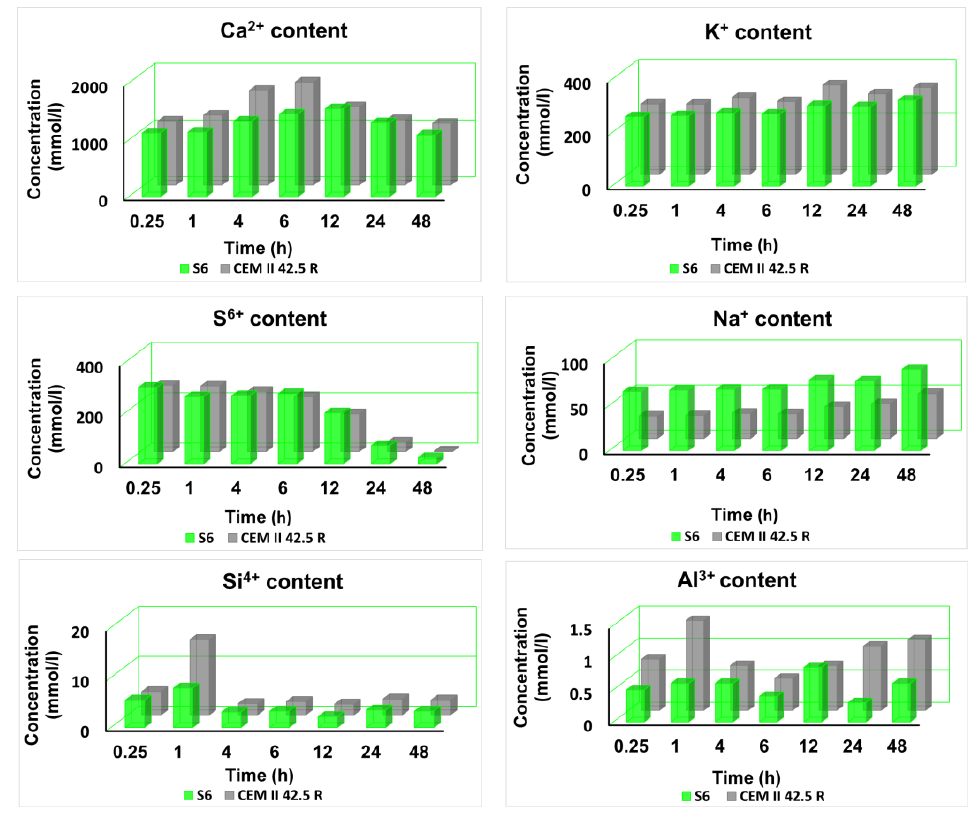
Figure 6. Pore solution chemistry of the only CEM II 42.5 R (grey) and of CEM II 42.5 doped with S6 (Table 1) (green).